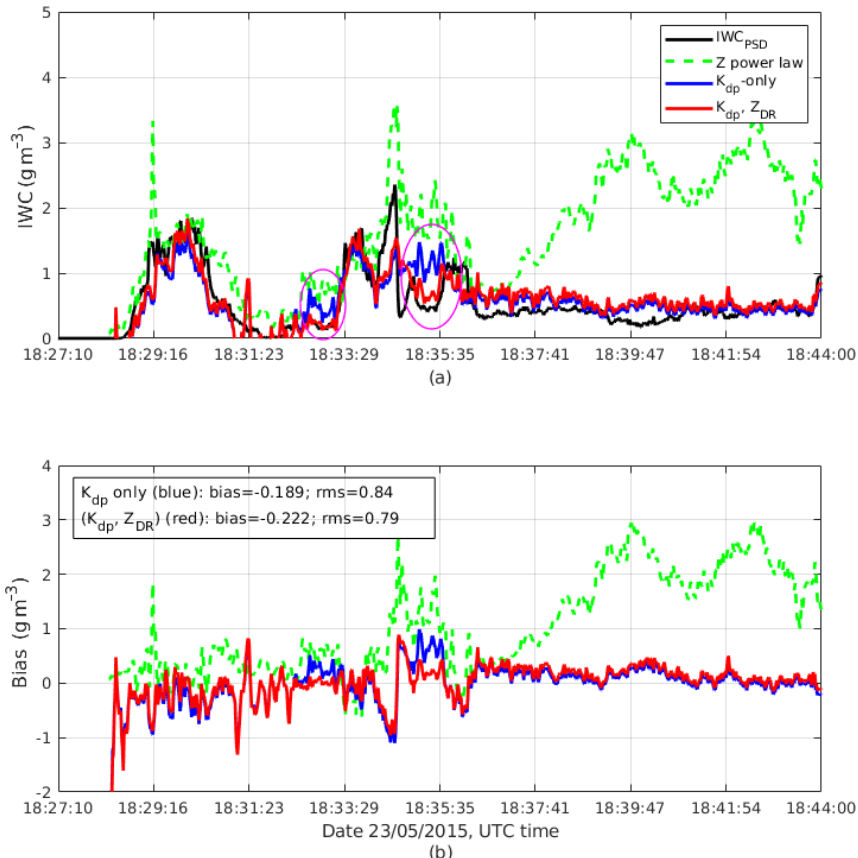
Figure 12. Similar to Fig. 7 but for the 23 May case. Average biases for IWC(Z), IWC( K dp ), and IWC( K dp , Z DR ) are 1, − 0 . 189, and − 0 . 222gm − 3 and rms differences are 1.34, 0.84, and 0.79gm − 3 for the algorithms, respectively.